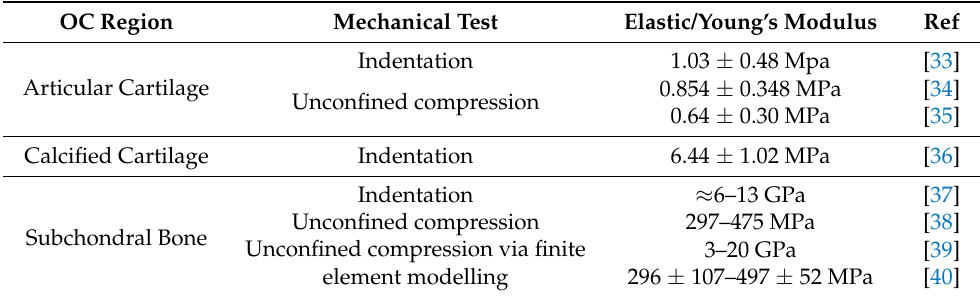
Figure 1. Gradient schematic of the OC tissue [31,32]. While the OC tissue is made up of articular cartilage, calcified cartilage and subchondral bone, each of these tissues are not homogenous. Especially in the articular cartilage, each zone within varies in cell size, number and orientation as well as collagen fiber size and orientation. Overall trends of the full OC unit are summarized in the ascending and descending triangles. Table 1. Compressive-based mechanical properties of the human OC tissue.